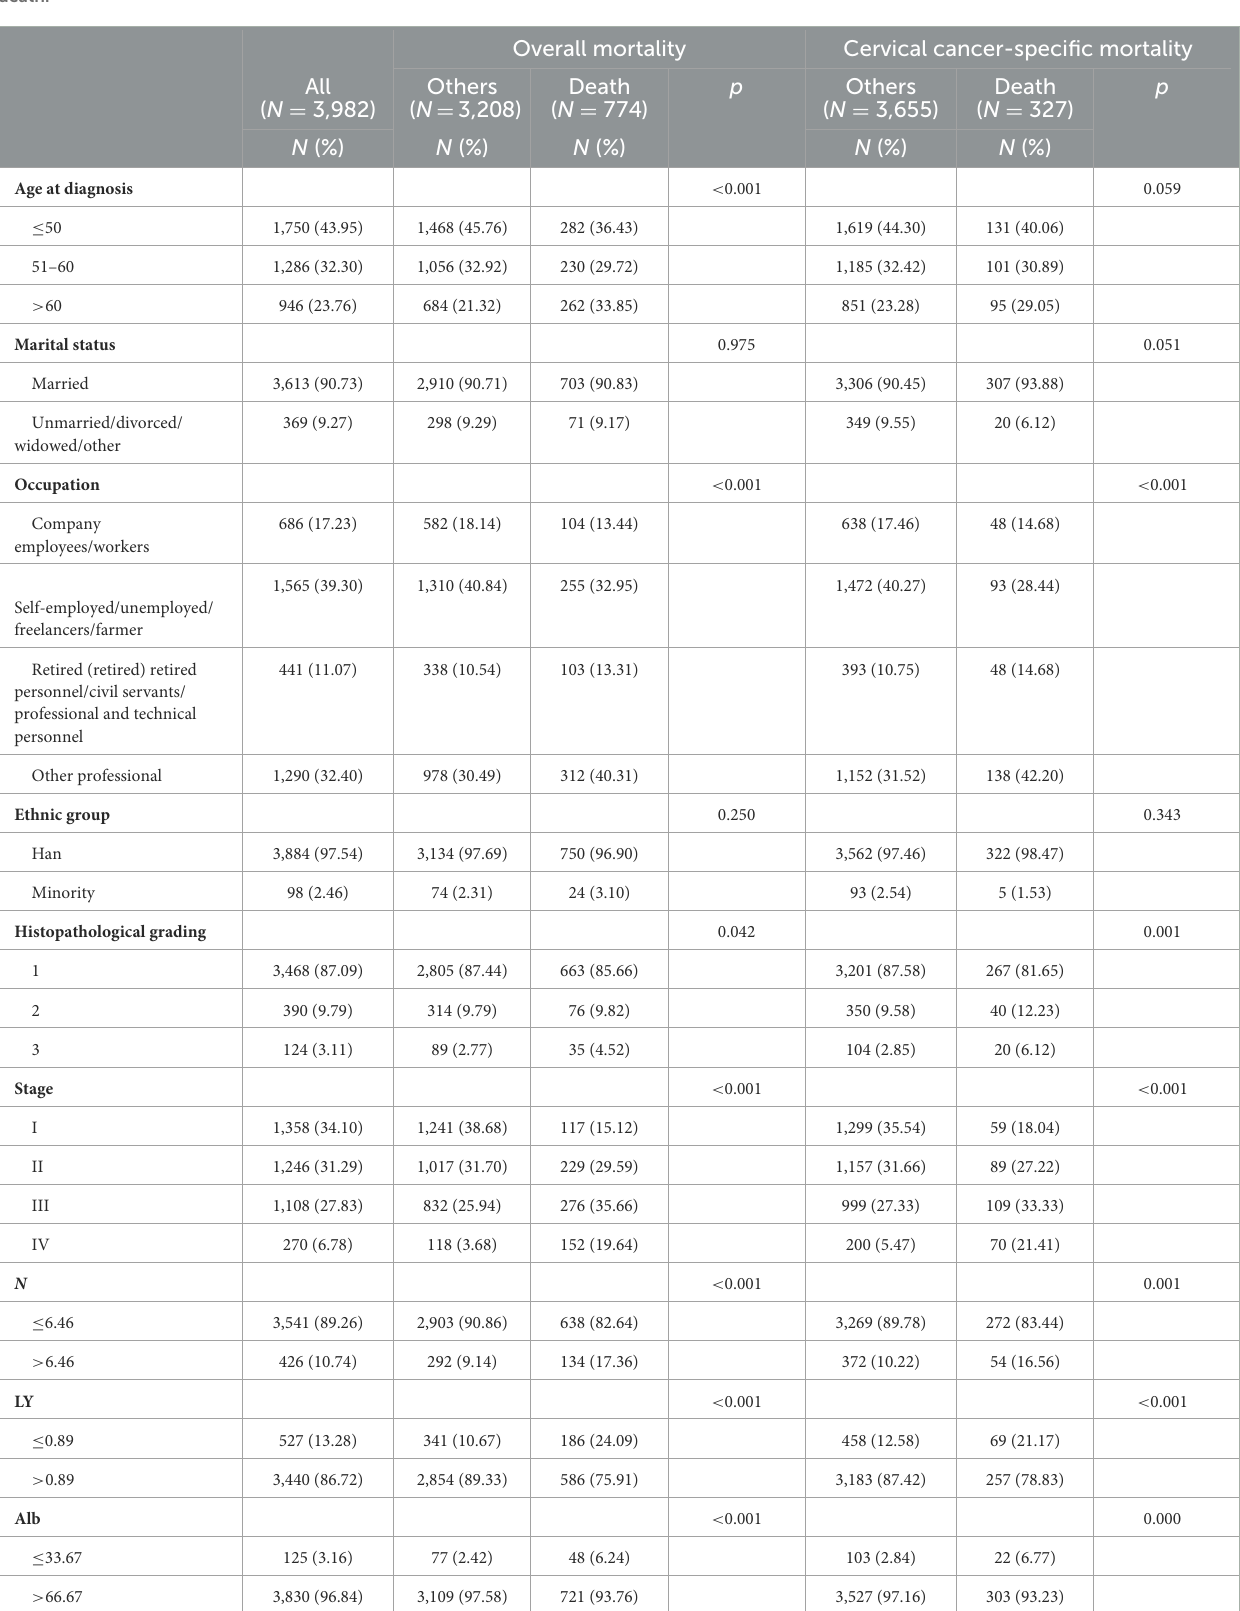
TABLE 2 Associations of demographic factors, the clinical characteristics, and treatment types with cervical cancer-specific mortality and all cause death. Overall mortality Cervical cancer-specific